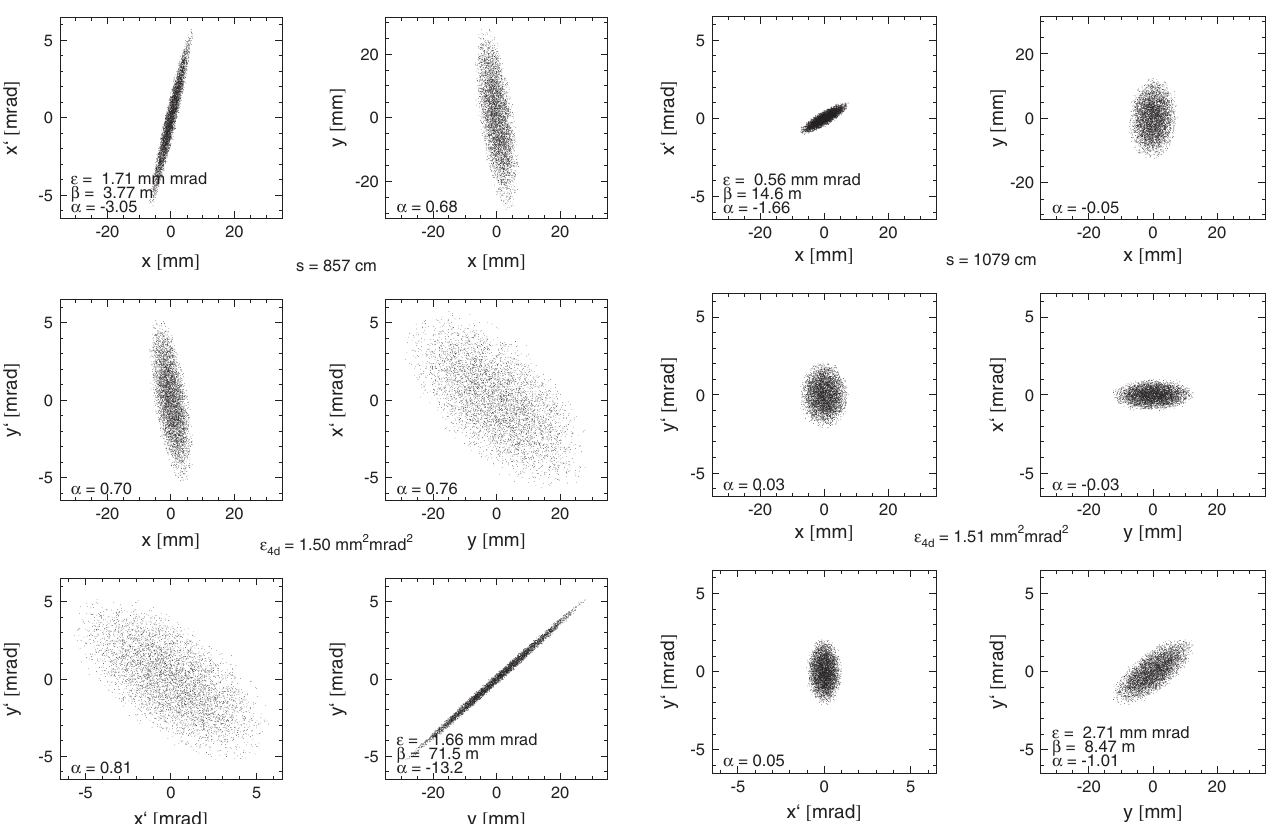
FIG. 14. Two-dimensional projections of the transverse phase space distribution at the exit of the proposed emittance transfer section along the UNILAC. Horizontal and vertical rms Twiss parameters are indicated as well as the four interplane correla- tion parameters.